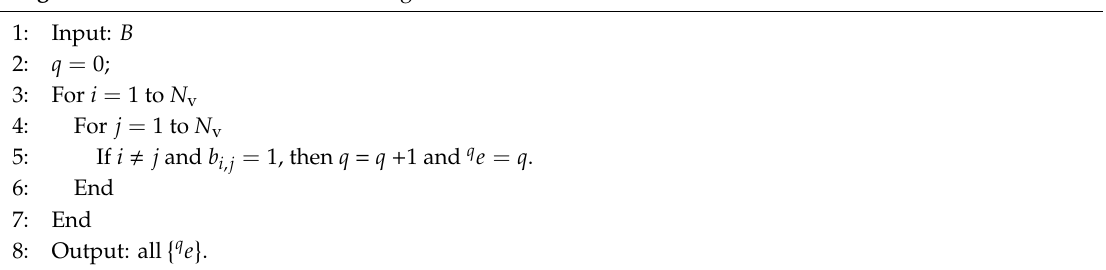
Algorithm 1 Determine the index of edge